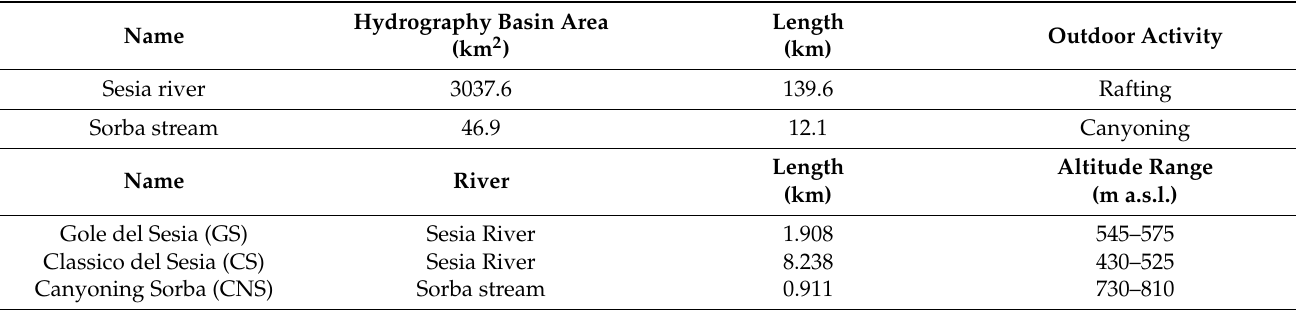
Table 3. The 2 rivers and the 3 selected river segments for the